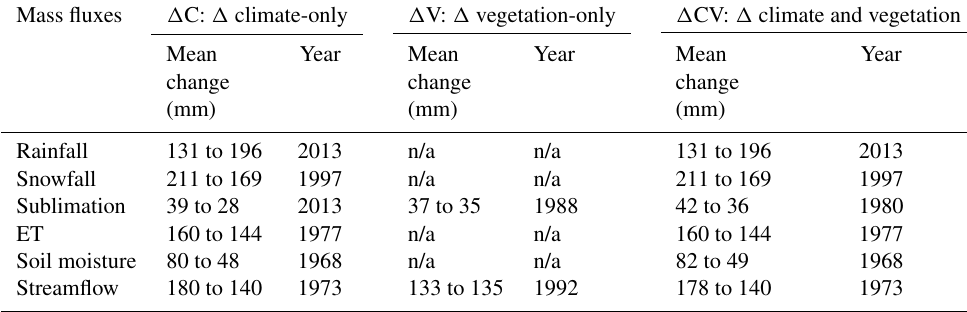
Table 4. Change point analysis for selected annual basin-scale mass fluxes for the three modelling scenarios.